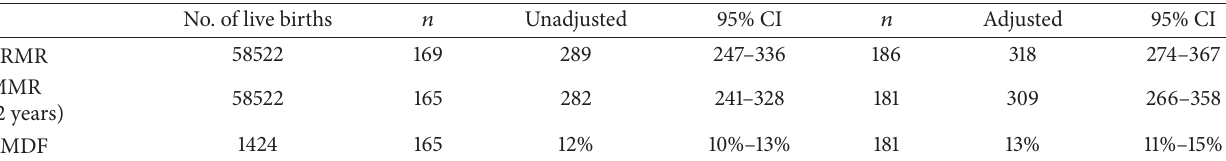
Table 1: MMR estimates for Chakwal district.